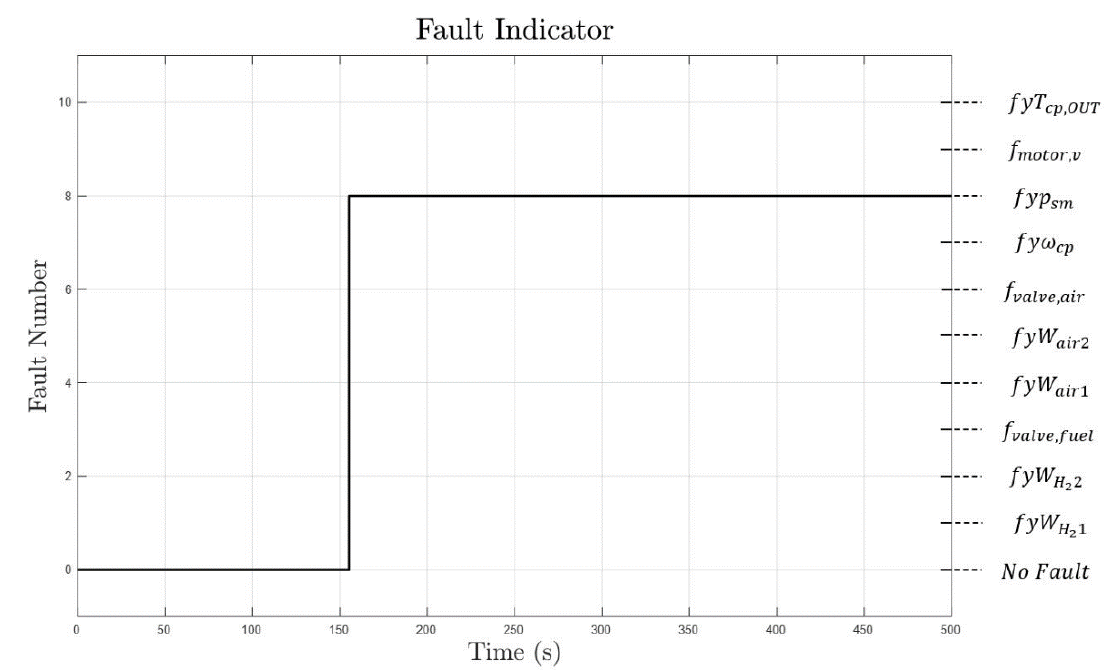
Figure 11. Fault indicator in case of air pressure sensor fault.